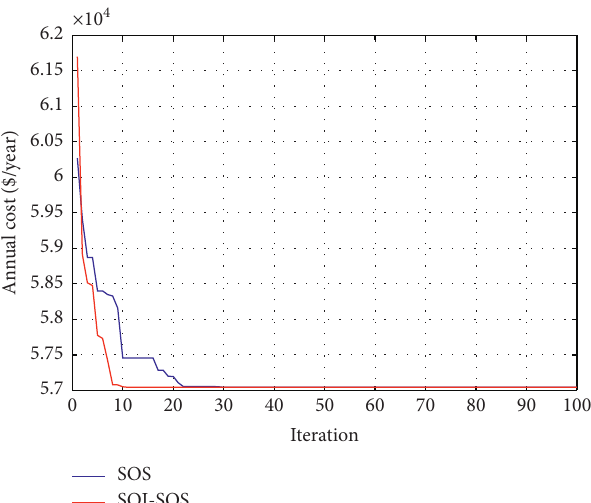
Figure 9: Convergence curves of the total cost of the 69-bus system with the CP load model at 100%